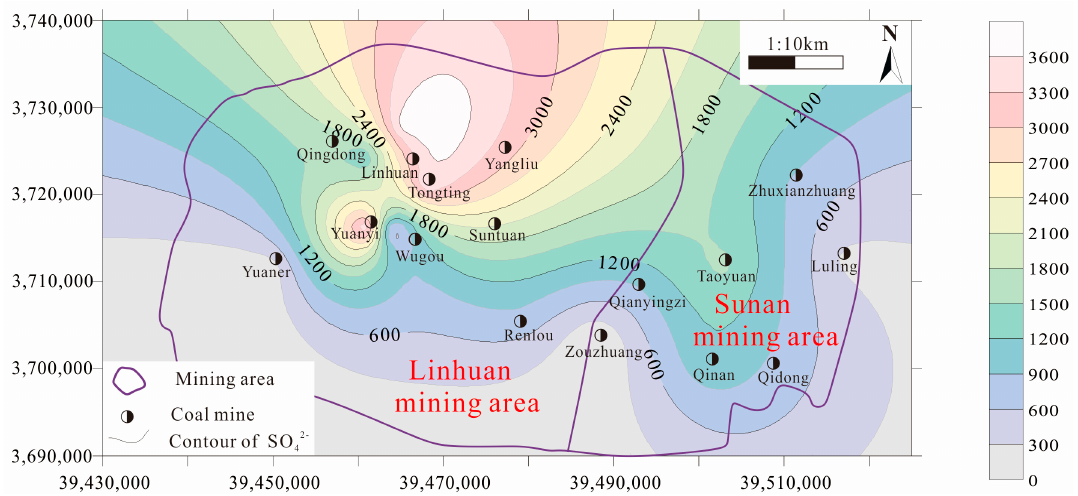
Figure 3. SO 42 − contour map of the Taiyuan formation limestone water in the study area. Figure 3. SO 4 2 − contour map of the Taiyuan formation limestone water in the study